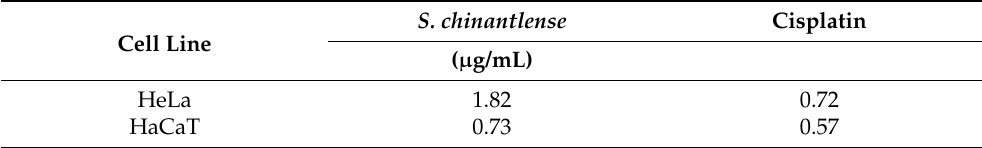
Figure 1. Effect of different S. chinantlense extract concentrations on the proliferation of HeLa and HaCaT cell lines. The proliferation of HeLa and HaCaT cells was evaluated after 72 h in the presence of S. chinantlense extract or cisplatin. Average values of three independent experiments ± S.D. * p < 0.01 ANOVA — Tukey ’ s test with respect to the control of each cell line. Table 1. Mean concentration of inhibition of cell proliferation [IC 50 ] (µg/mL) induced by S. chinantlense extract or cisplatin in HeLa and HaCaT cell lines.